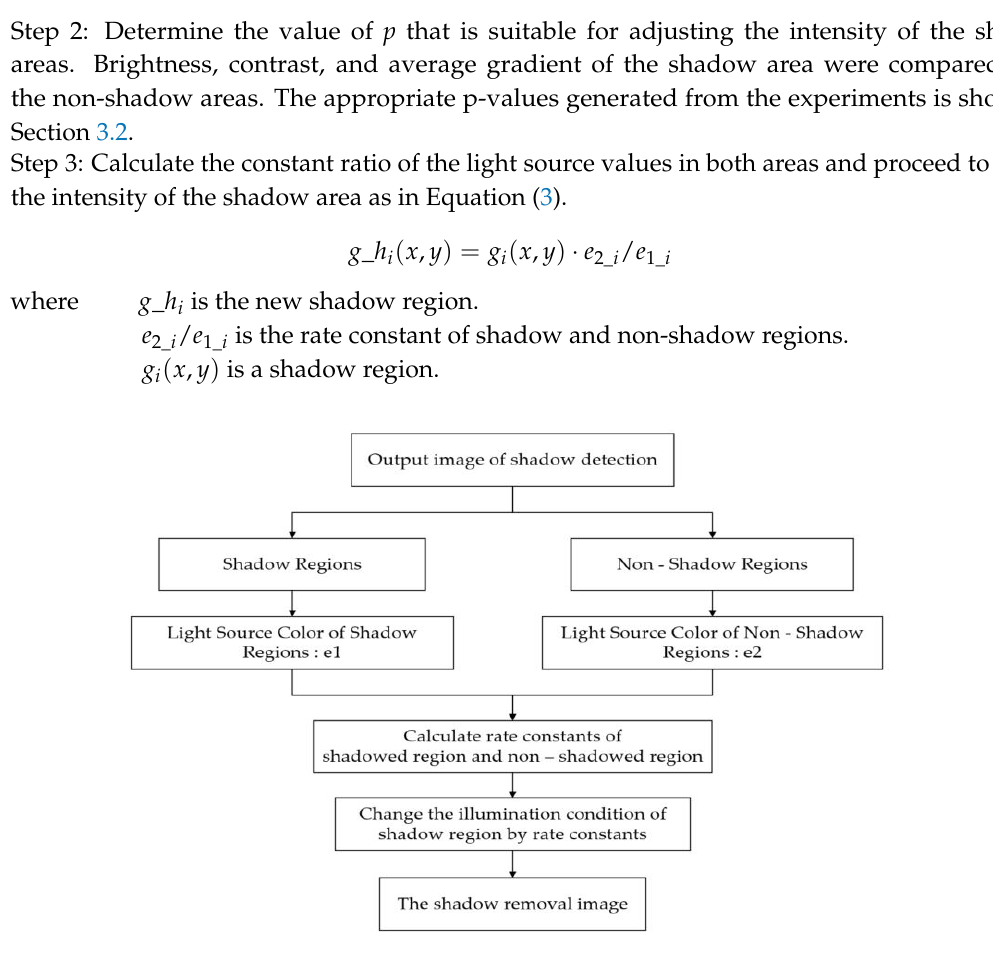
Figure 6. Overview of shadow